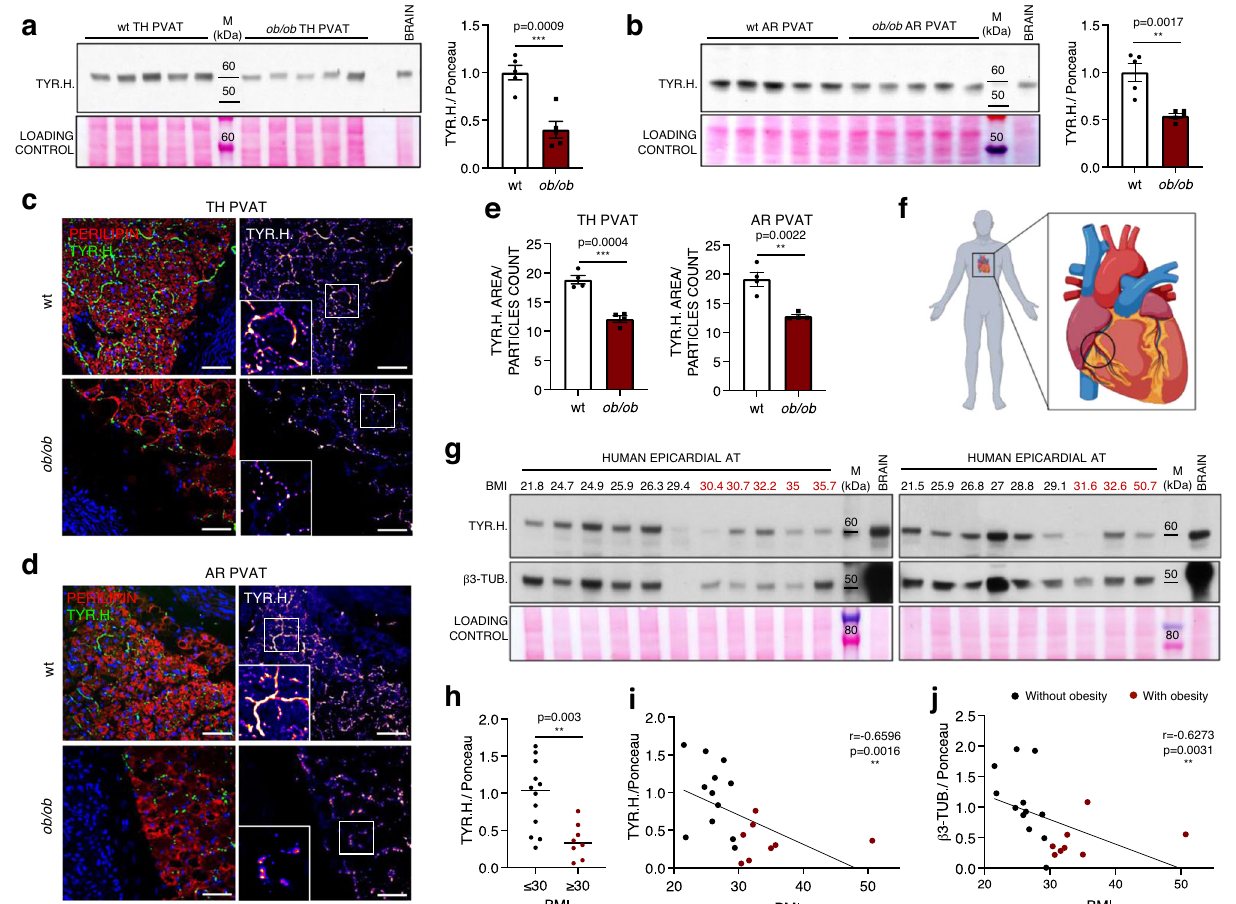
Fig. 4 | Sympathetic innervation of murine and human AT depots in obesity. a , b Western blots showing TYR.H. abundances in wt and ob/ob TH ( a ) and AR ( b ) PVAT lysates and relative quanti fi cations. N =5 biological replicates per group, unpaired, two-tailed independent t -test (unequal distribution). Bar charts show mean±SEM. c , d Representative immuno fl uorescence images showing TYR.H. distribution (in green and fi re) in wt and ob/ob TH ( c ) and AR ( d ) PVAT sections. Adipocytes are labelled by perilipin (in red), nuclei are counterstained with DAPI. Insets show higher magni fi cations of framed areas. Scale bar: 50 µ m. e Bar charts showingtheaveragesizeofTYR.H.positiveparticles(mean±SEM)obtainedfrom4 mice per condition, with 5 to 10 sections analysed in each mouse. N =4, unpaired two-tailed independent t -test (unequal distribution). f Schematic cartoon showing